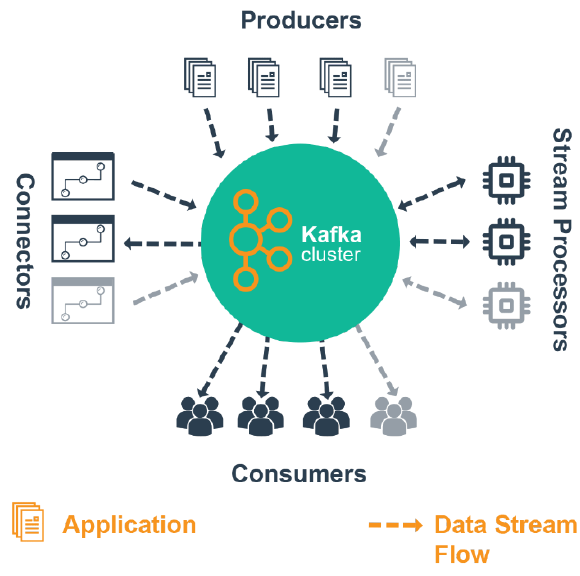
Figure 2. A simple Apache Kafka ecosystem [16].